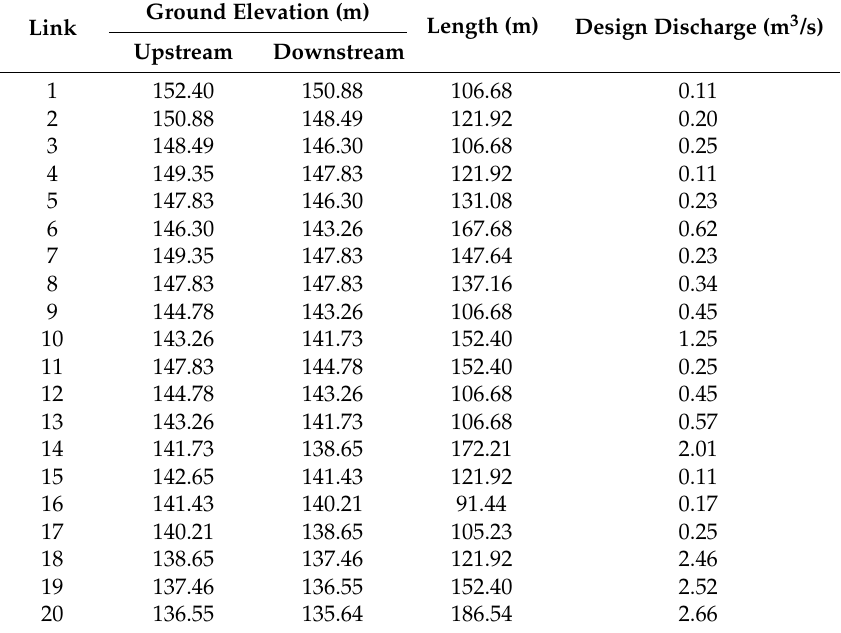
Table 2. Summary of basic storm sewer information in case